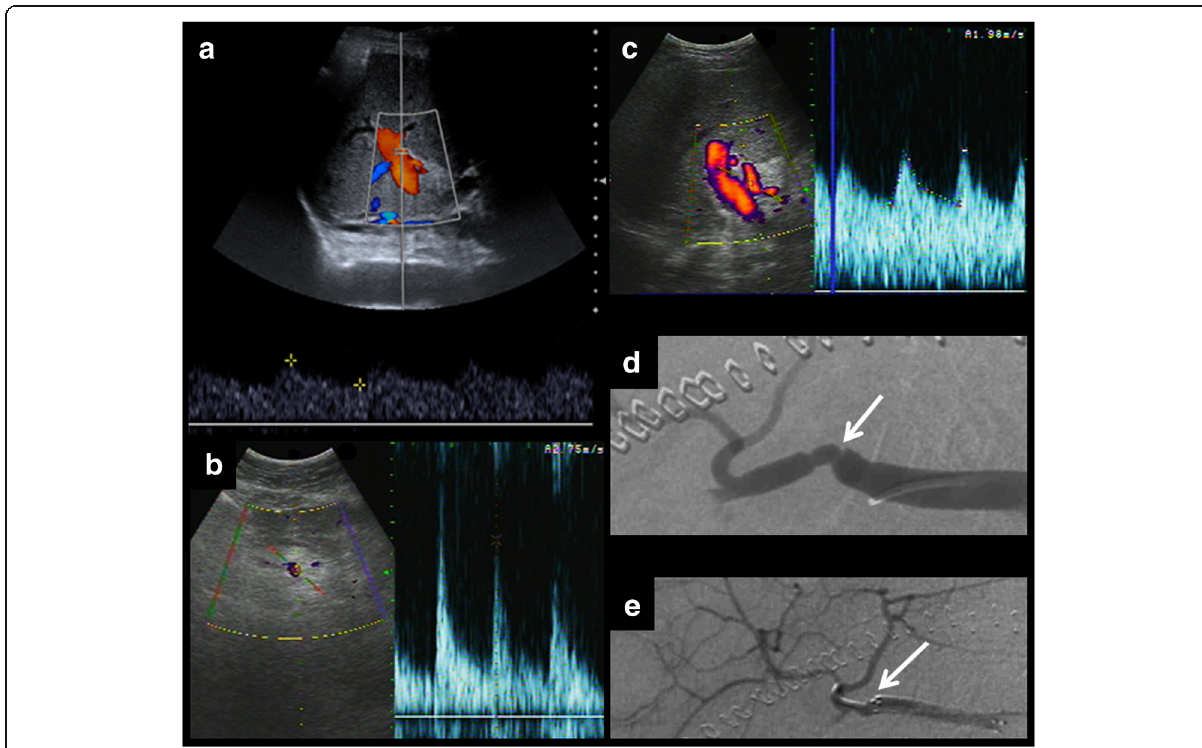
Fig. 4 The usefulness of spectral curves on the assessment of hepatic artery stenosis. Even in cases of normal colour Doppler examination ( a ), spectral curves should be obtained. They show a characteristic pattern before and after the stenosis. In the prestenotic segment ( b ), we can appreciate high peaks and an elevated resistive index. In the poststenotic segment ( c ), we can see a parvus et tardus pulse and a low resistive index. Angiography can help confirm the diagnosis ( d ) and perform the treatment ( e )